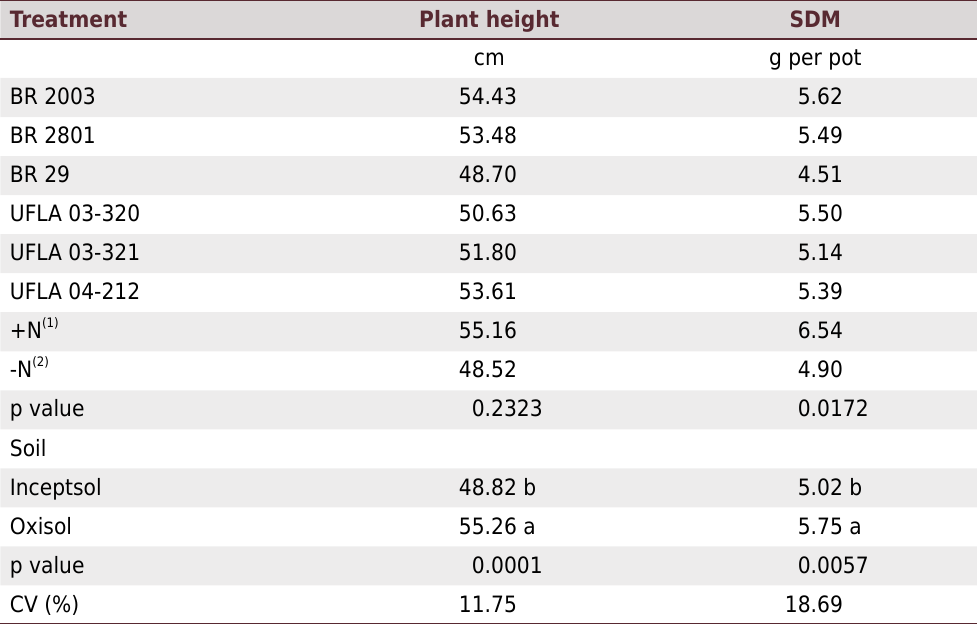
Table 5. Plant height and shoot dry matter (SDM) of pigeon pea cv. IAC Fava-Larga cultivated in pots with soil Treatment Plant